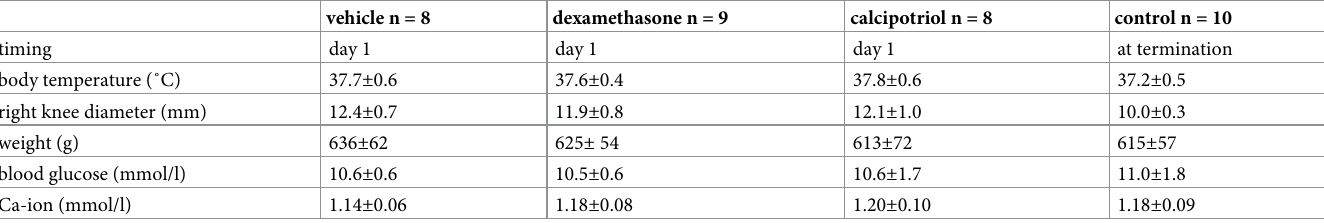
Table 1. Clinical and laboratory values of rats in different arthritis groups at baseline (day 1) and at